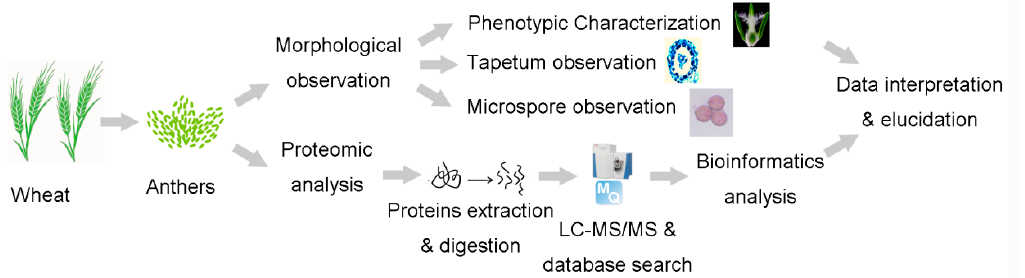
Figure 1. Outline of experimental workflow.